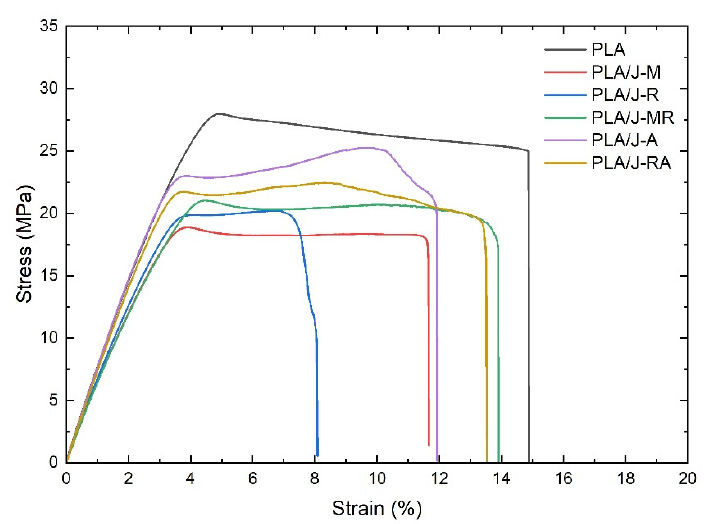
Figure 2. Stress vs strain curves corresponding to PLA and PLA composites.